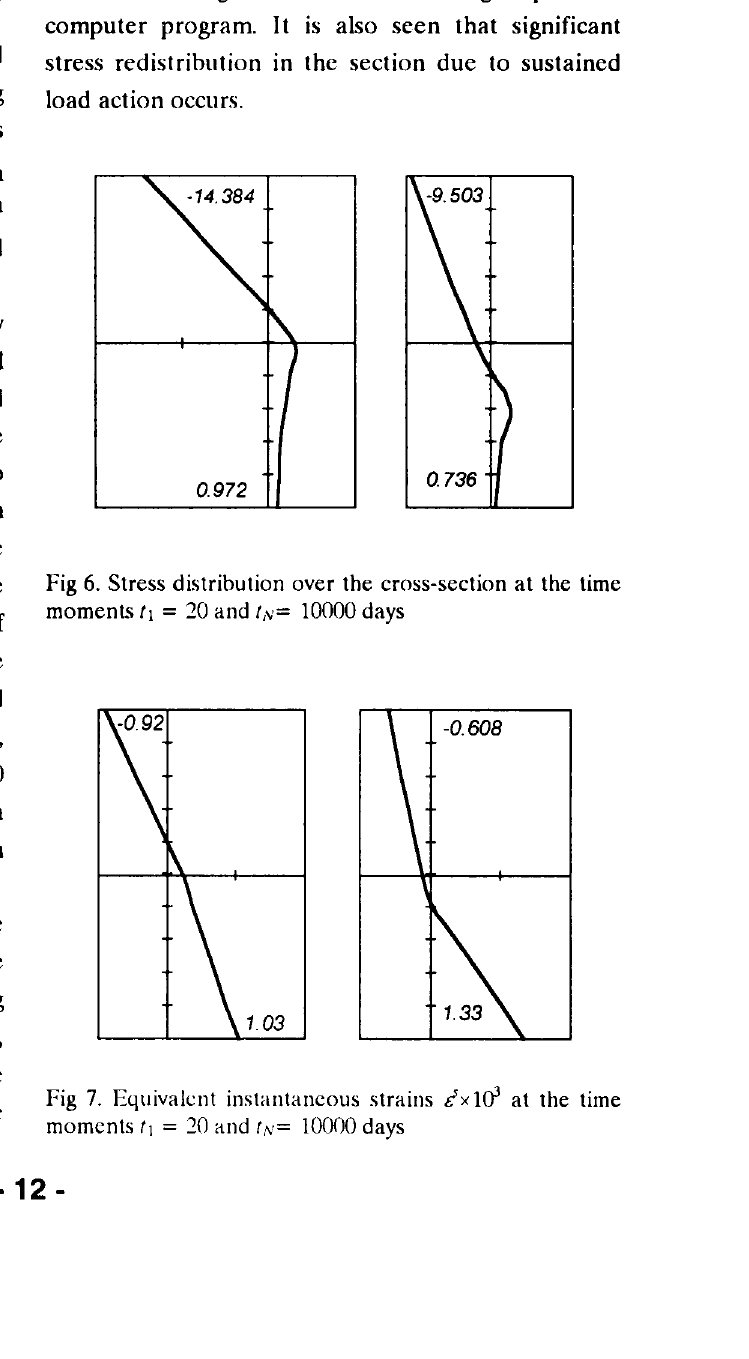
1.03 Fig 7. Equivalent instantaneous strains ix leY at the time moments f1 = 20 and r.~·= 10000 days -